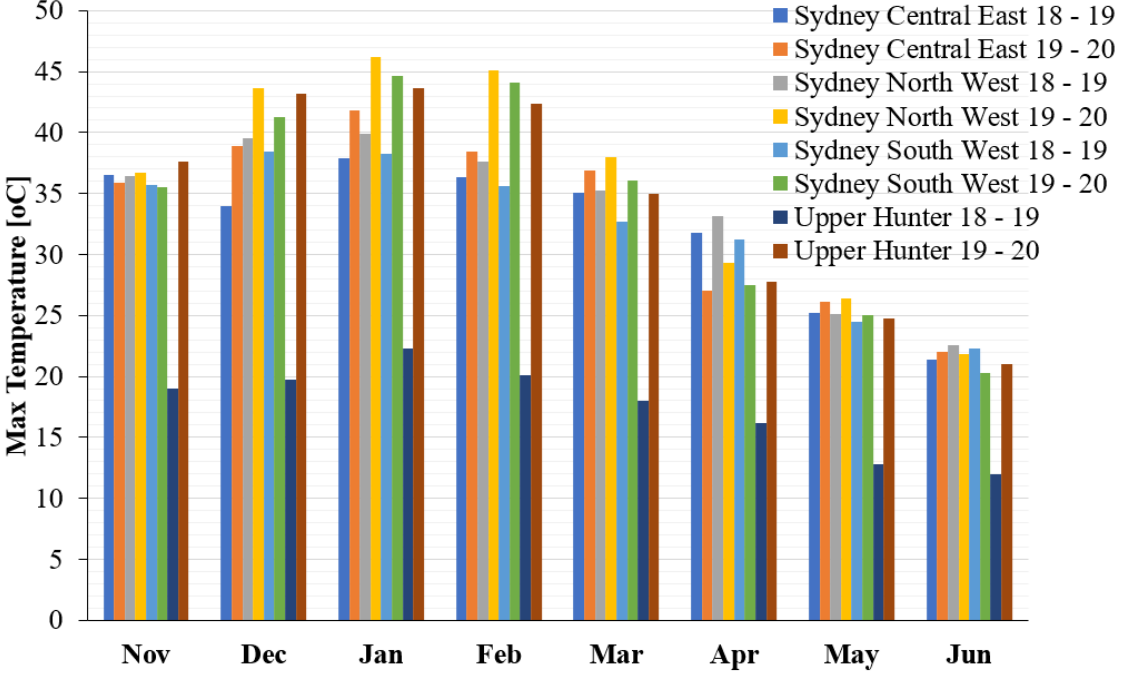
Figure 4. Maximum monthly temperature at different locations of NSW for a wide range of periods.